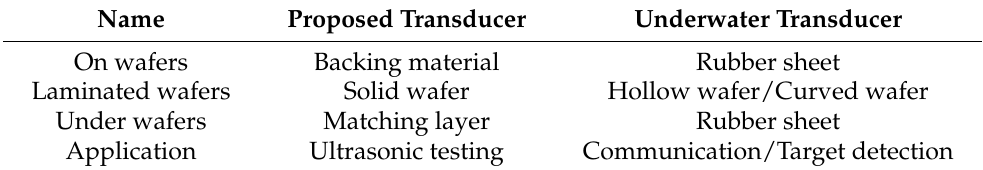
Table 1. Differences between proposed and underwater